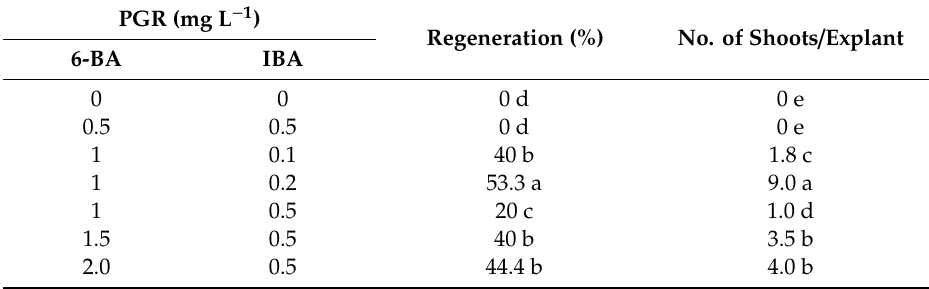
Table 2. Effect of plant growth regulators on shoot regeneration from a protoplast-derived callus of Petunia hybrida cv. Mirage Rose.